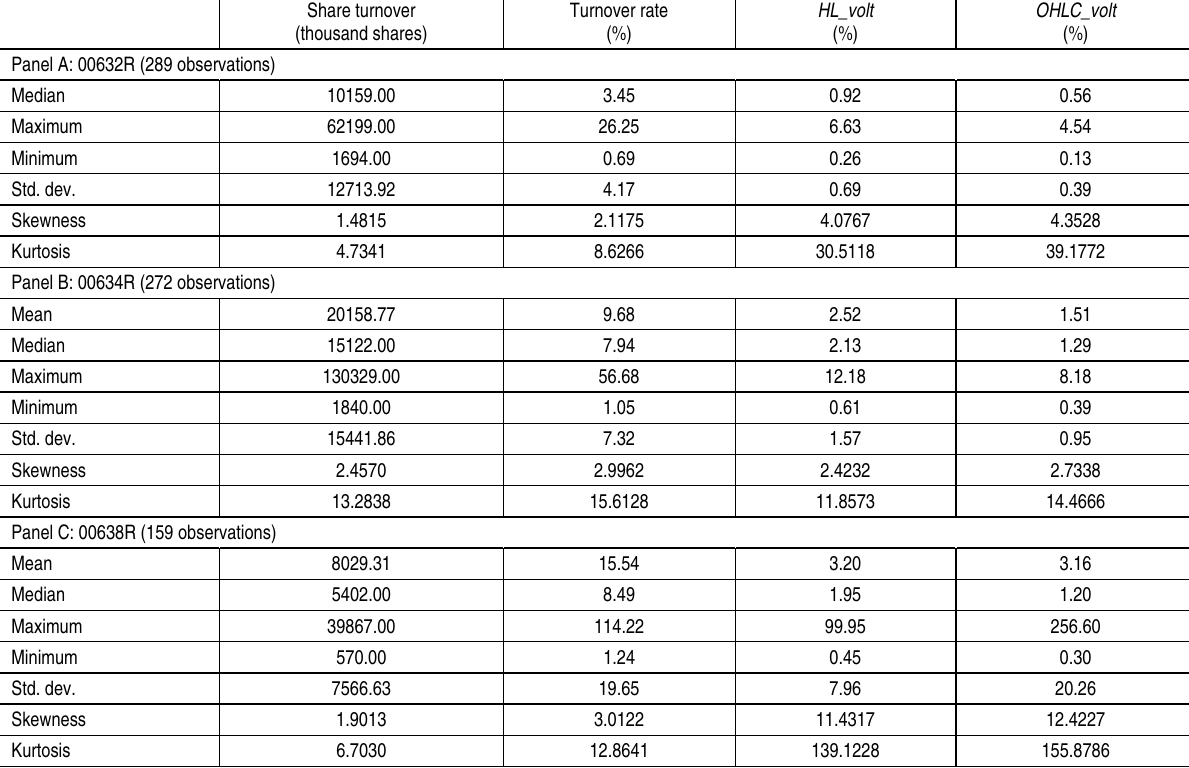
Table 1 (cont.). Summary statistics for the trading-activity variables of the three inverse ETFs